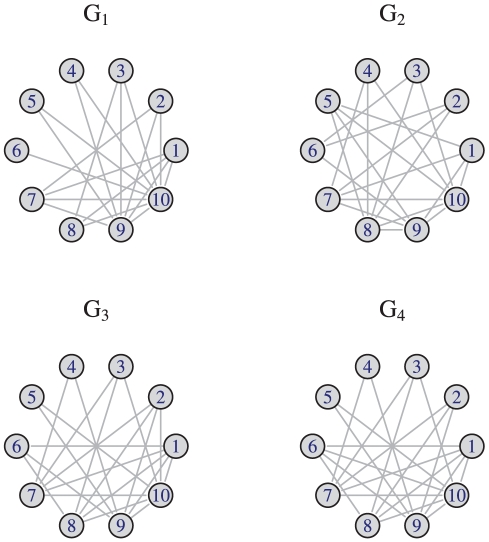
Four example graphs

.